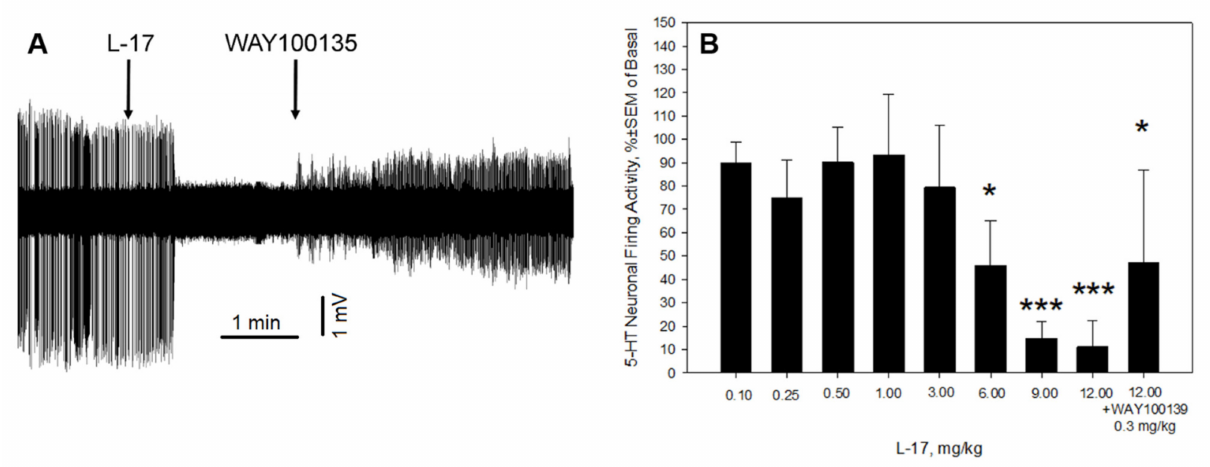
Figure 5. L-17 significantly and dose-dependently inhibited the firing activity of 5-HT neurons. ( A ): representative recording from a 5-HT neuron during L-17 (12 mg/kg) and WAY100135 (0.3 mg/kg) administration. ( B ): Summary effect of L-17 (0.1–12 mg/kg) and WAY100135 (0.3 mg/kg) on the spontaneous firing activity of 5-HT neurons of the DRN (data from 8 neurons from 7 rats).* p < 0.05 and *** p < 0.001, Bonferroni post-hoc